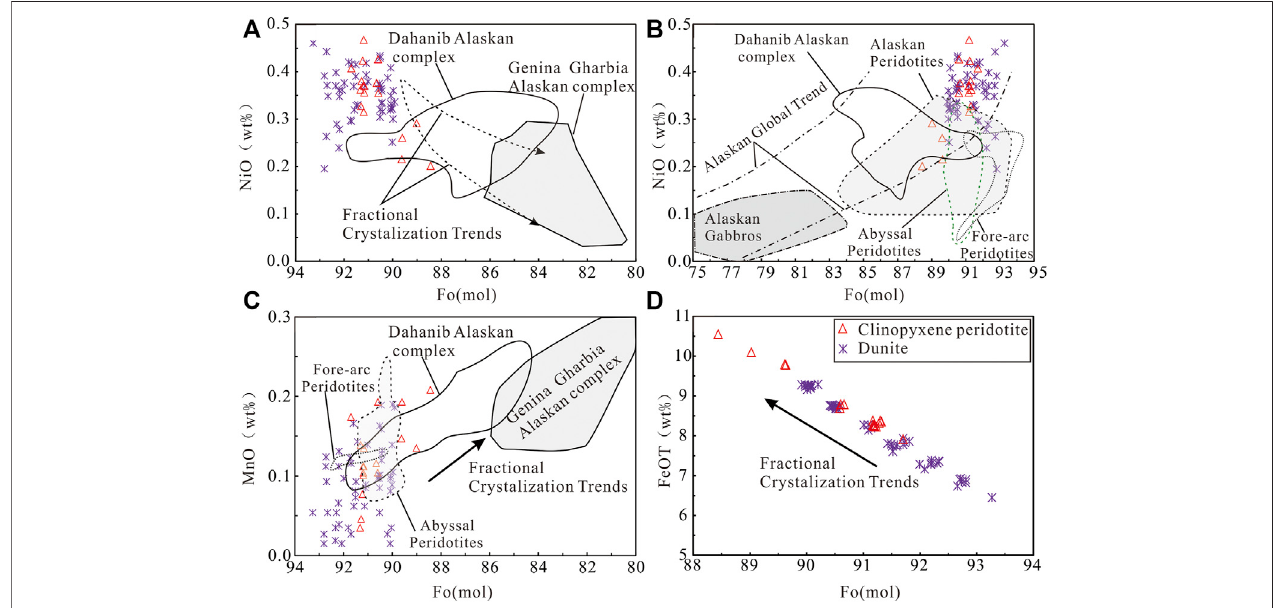
FIGURE10| OlivinechemistryoftheHongshishan duniteand clinopyroxene.PlotsofFoversusNiO (wt%),MnO (wt%) showingtheolivinesfollowingthefractional crystallization trend and Alaskan global trend. The fi elds of Dahanib and Genina Gharbia are from Khedr et al. (Khedr and Arai., 2016). The fi elds of the Alaskan global trend and Alaskan gabbros are after Krause et al. (2007), and the fi elds of Abyssal peridotites and Fore-arc peridotites are from Pagé et al. (2008).